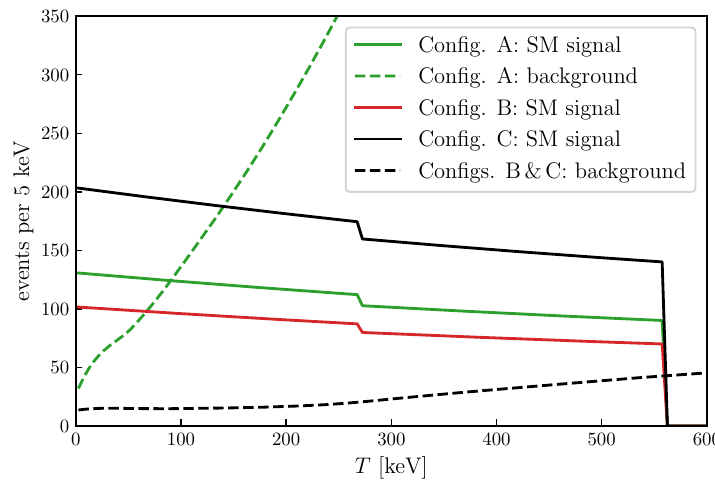
Figure 1 . Signal compared to background in the 51 Cr-LXe experiment. Three configurations (A, B, C) are considered, with the details described in table 1. Configurations B and C have much larger signal/background ratios than